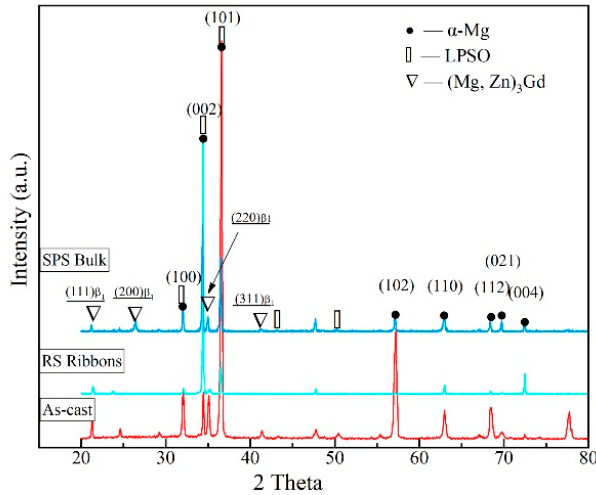
ff erent conditions.